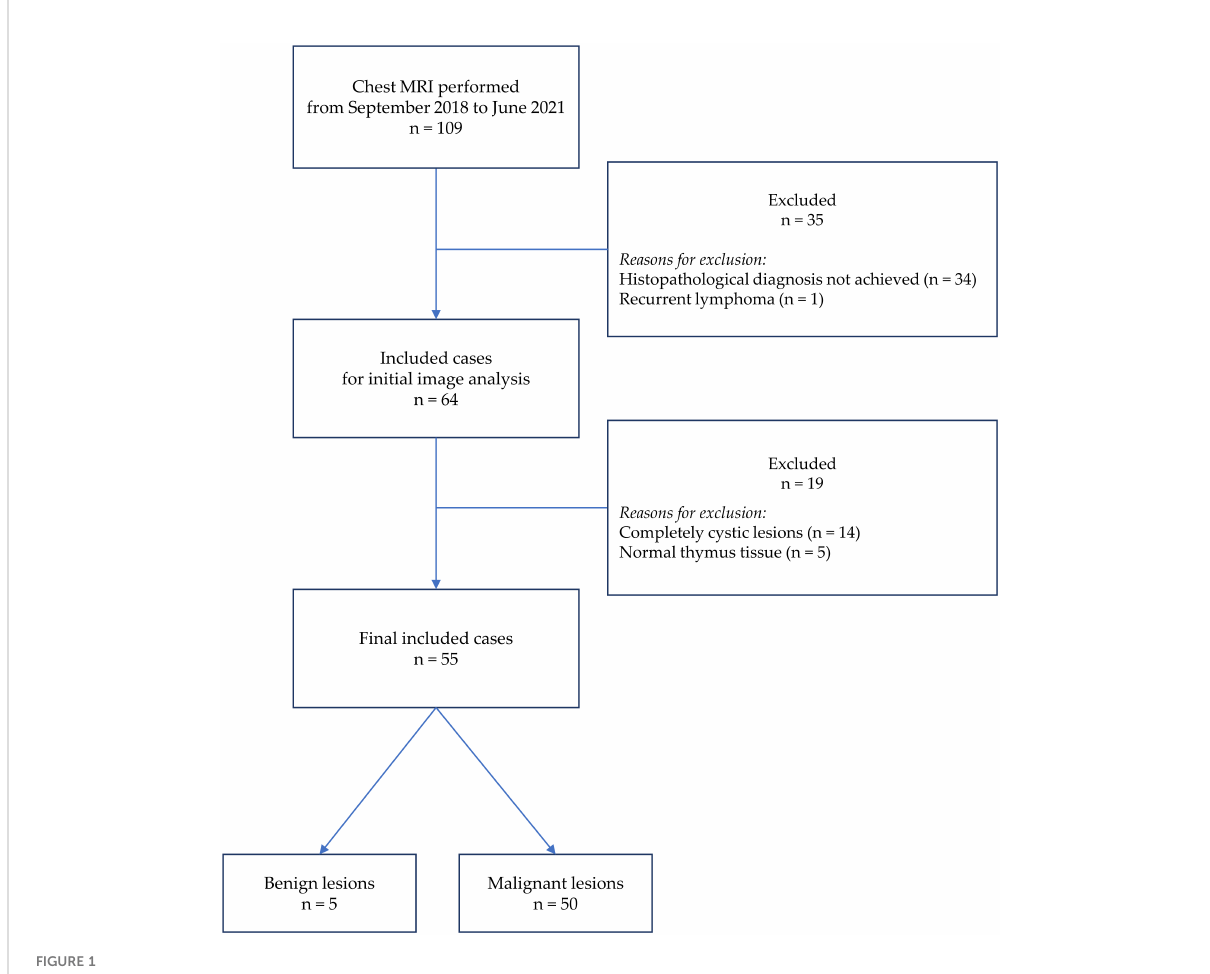
FIGURE 1 The fl ow diagram of sample